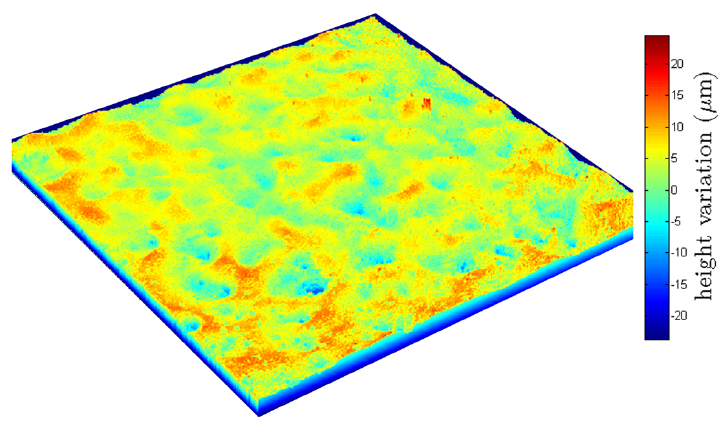
Figure 13. Topography of the GESA modified sample surface obtained by white-light interferometry [48,49], revealing the coating roughness ( R RMS value around 2.18 µ m) on a mm